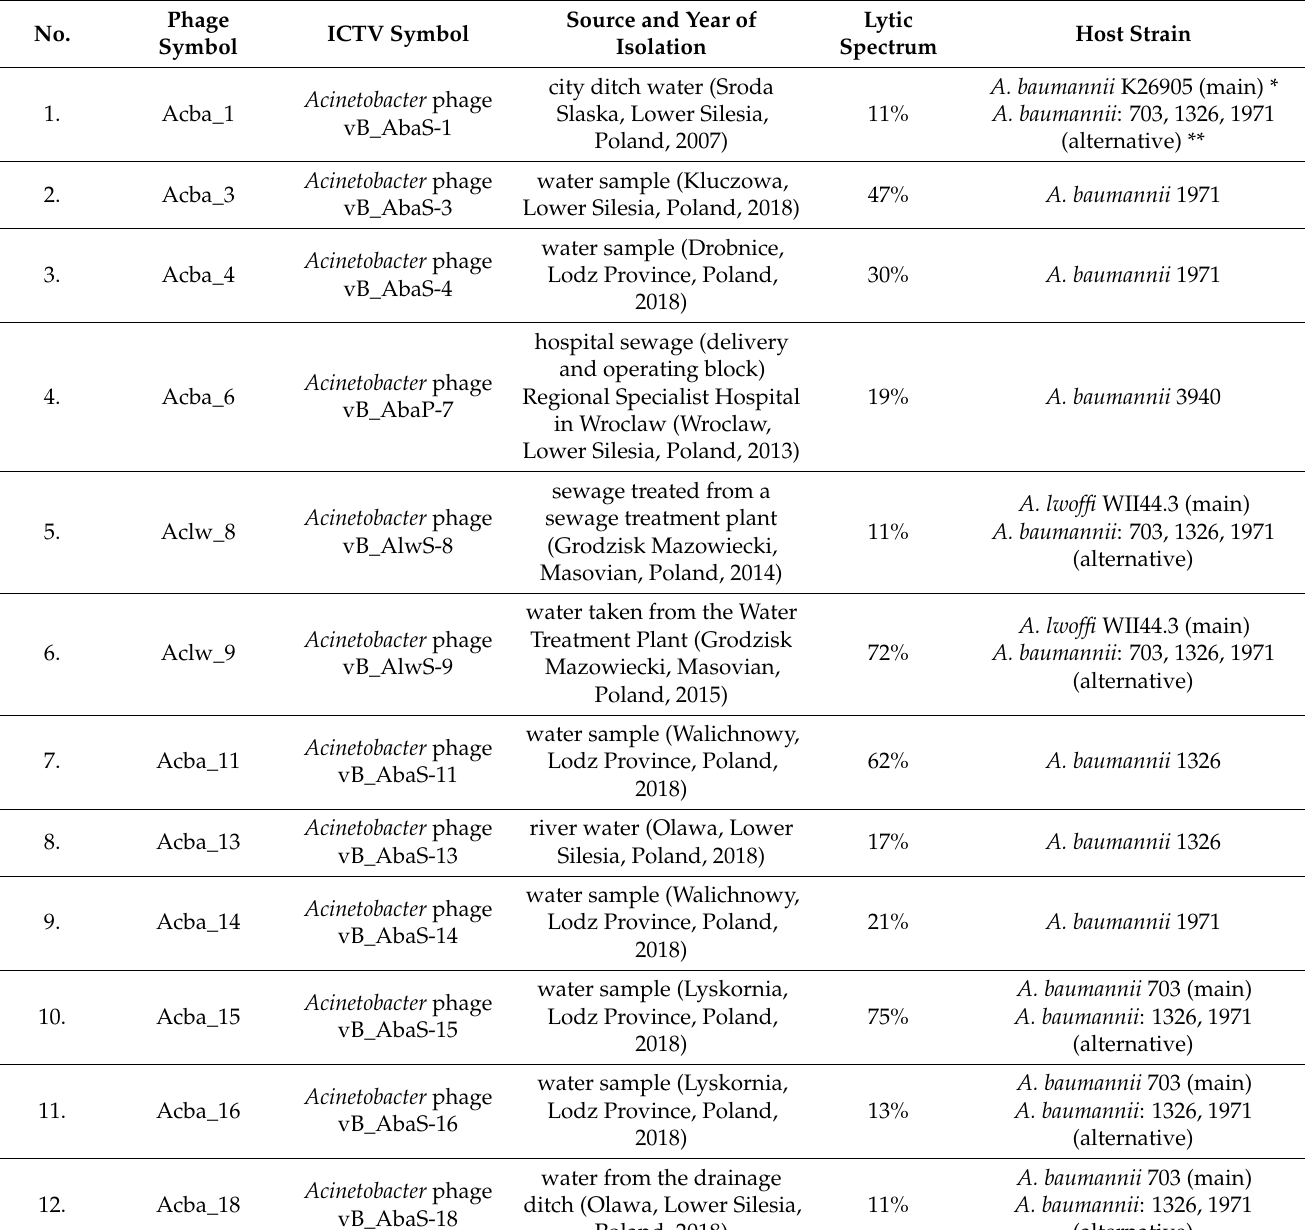
Table 2. Characterization of phages specific for A. baumannii . The lytic spectrum was tested with 53 strains of A. baumannii